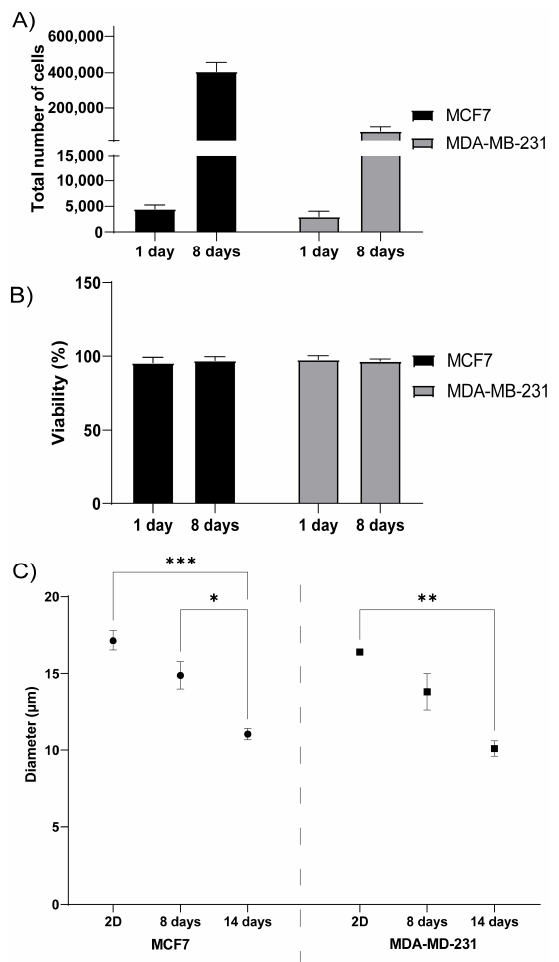
Figure 3. 3D printed TEMPO-CNF as a suitable scaffold for breast cancer cells. ( A ) Total number of MCF7 and MDA-MB-231 breast cancer cells quantified after 1- and 8-days culture, respectively, in 3D printed TEMPO-CNF scaffolds, n = 6–9. ( B ) Viability of MCF7 and MDA-MB-231 cells quantified after 1- and 8-days culture, respectively, in 3D printed TEMP-CNF scaffolds, n = 6–9. ( C ) Quantification of cell diameter of MCF7 and MDA-MB-231 cells cultured in 2D or in 3D printed TEMPO-CNF scaffolds for 8 and 14 days, respectively, n = 3–9. ( A – C ) Average ± standard error of the mean. Two-way ANOVA; Sidak’s post hoc test for multiple comparison. * p -value < 0.05, ** p -value < 0.01, *** p -value < 0.001.